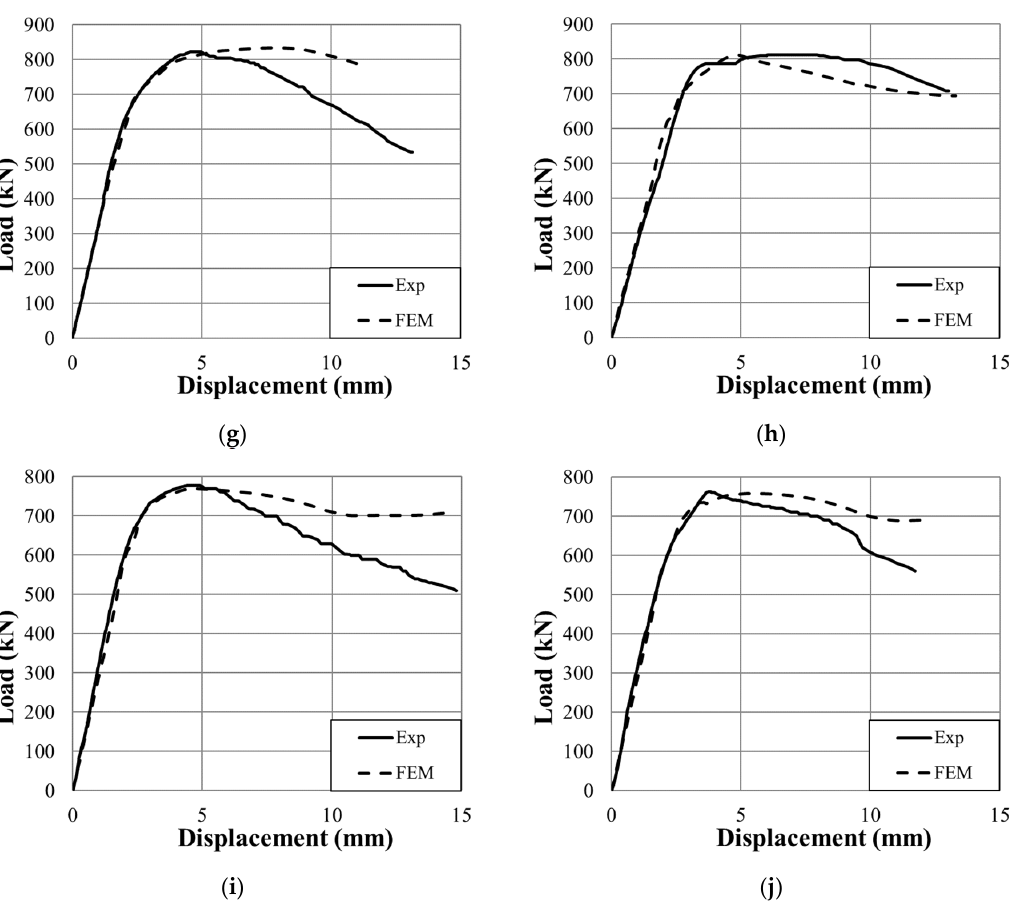
Figure 10. Load–displacement response for the square specimens from the experiment and the finite element model. ( a ) S100, ( b ) S100/32, ( c ) S100/32-18 a -10 t , ( d ) S100/32-18 a -20 t , ( e ) S100/32-18 a -30 t , ( f )